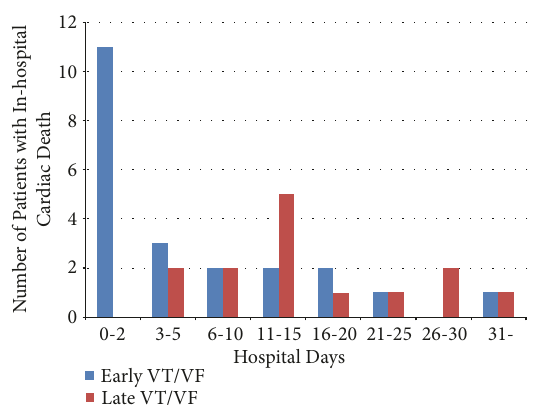
Figure 4: Timing and frequency of late VT/VF. VT/VF: ventricular tachycardia or ventricular fibrillation.